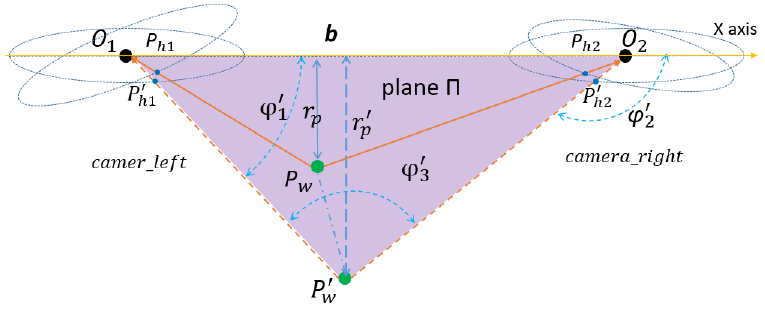
Figure 9. Coordinate systems of horizontal binocular stereo panoramic vision systems.